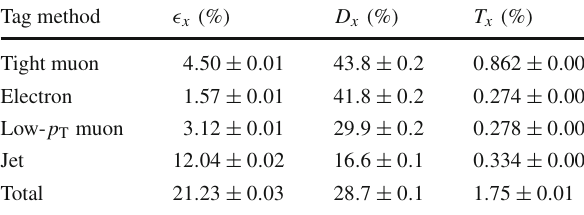
Table 1 Summary of tagging performances for the different flavour tagging methods on the sample of B ± signal candidates, as described in the text. Uncertainties shown are statistical only. The efficiency ( (cid:17) x ) and tagging power ( T x ) are each determined by summing over the indi- vidualbinsoftheconechargedistribution.Theeffectivedilution( D x )is obtained from the measured efficiency and tagging power. For the effi- ciency, effective dilution, and tagging power, the corresponding uncer- tainty is determined by combining the appropriate uncertainties in the individual bins of each charge